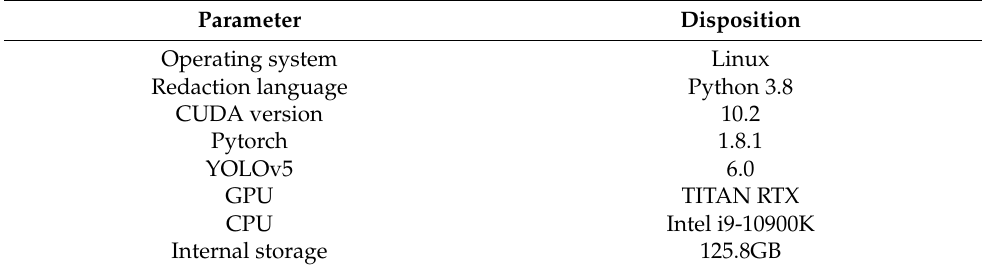
Table 1. Experimental parameter